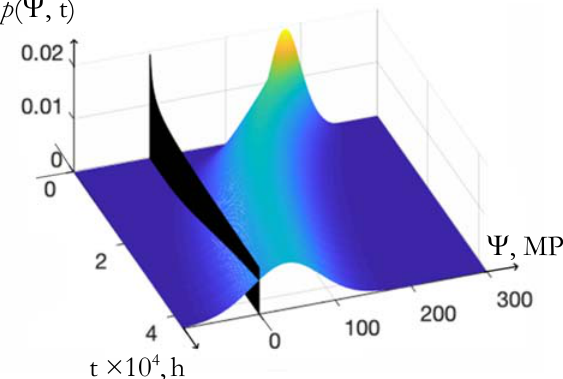
Figure 9: Example of function of the dependence of the reliability indicator on